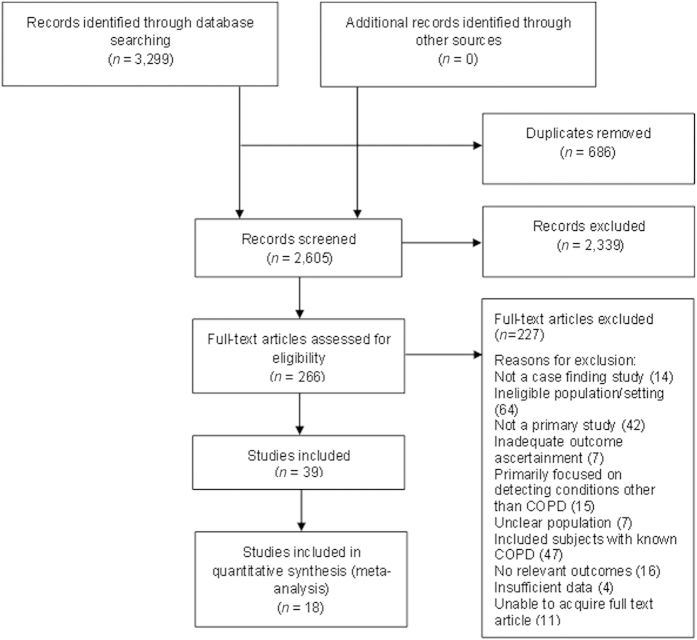
Article selection.